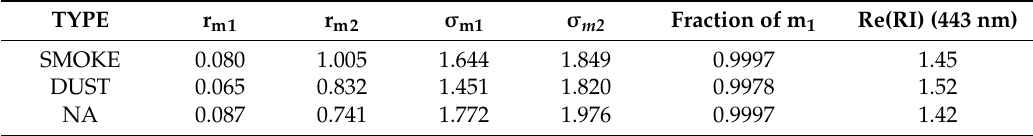
Figure 1. Comparison of model-simulated UVAI and SAI with respect to AOD, SSA, aerosol types, and aerosol layer height using VLIDORT. Solid lines indicate UVAI (354, 388 nm) and dashed lines indicate SAI (388 nm) using Equations (1) and (2). The aerosol’s SSA are indicated at top left. The surface albedo and terrain pressure are 0.05 and 1014 mb, respectively. The three aerosol types (smoke, dust, and NA) and their optical properties were obtained from AERONET lv.2 Inversion data using the aerosol classifying method of Lee et al. [27]. Table 1. Number-Weighted Particle Size Distributions and Refractive Indices of Aerosol Models Employed to Retrieve the Theoretical Value of SAI and UVAI using VLIDORT.